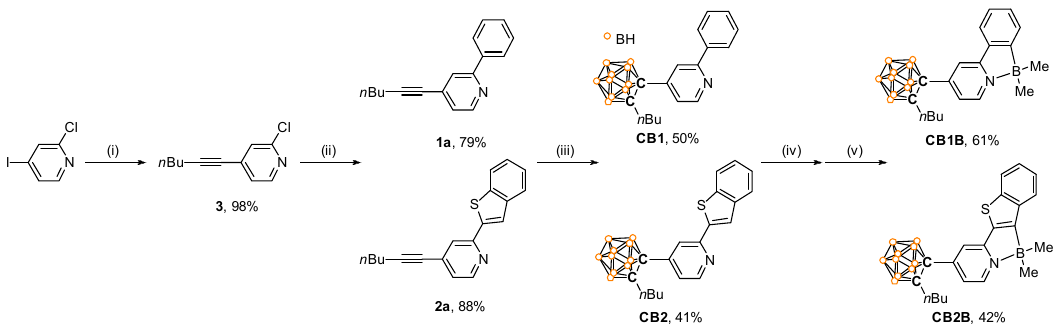
Figure 1. Synthetic procedure for o -carboranyl compounds ( CB1 , CB2 , CB1B , and CB2B ). Reaction conditions: (i) 1-hexyne, CuI, PdCl 2 (PPh 3 ) 2 , NEt 3 /toluene, r.t., 24 h. (ii) Pd(PPh 3 ) 4 , Na 2 CO 3 , THF/H 2 O